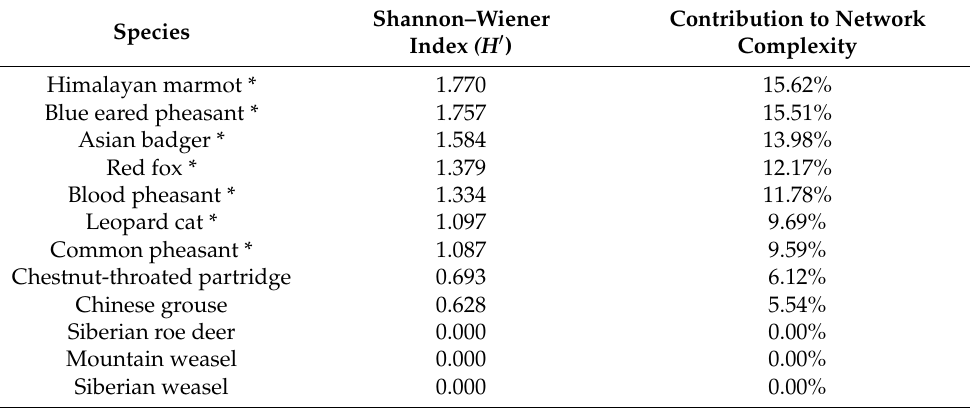
Table 3. Contribution of species to network